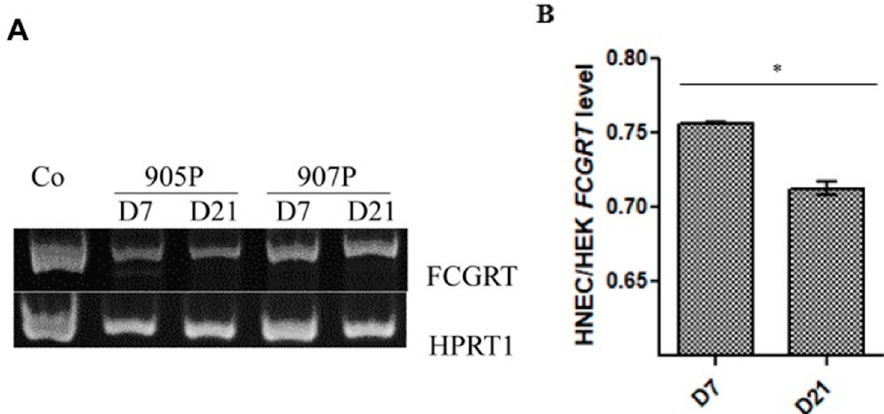
Figure 2. FCGRT mRNA expression in air–liquid interface culture of human nasal epithelial cells. RT-PCR with HPRT1 used as housekeeping gene ( A ) and qRT- PCR ( B ) showing amplification of FCGRT mRNA isolated from five different cultures (905P, 907P, and 895P for PCR and 954P and 956P for quantitative PCR) of human nasal epithelial cells (HNEC) on day 7 (D7) and day 21 (D21). HEK 293 was included as positive control (Co). FCGRT expression in HNEC were then reported to the expression level of HEK control cell line. Results are presented as mean +/ − SEM. * p < 0.05.